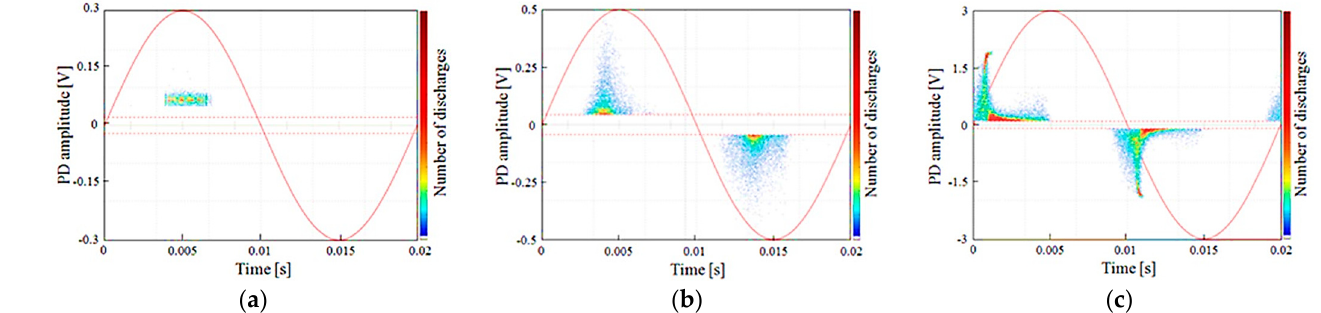
Figure 2. PRPD patterns (colored points) showing the magnitude of all recorded discharge events ( y ‐ axis) plotted against time ( x ‐ axis) compared to the excitation AC for: ( a ) corona discharge, ( b ) surface discharge, and ( c ) internal discharge [39].